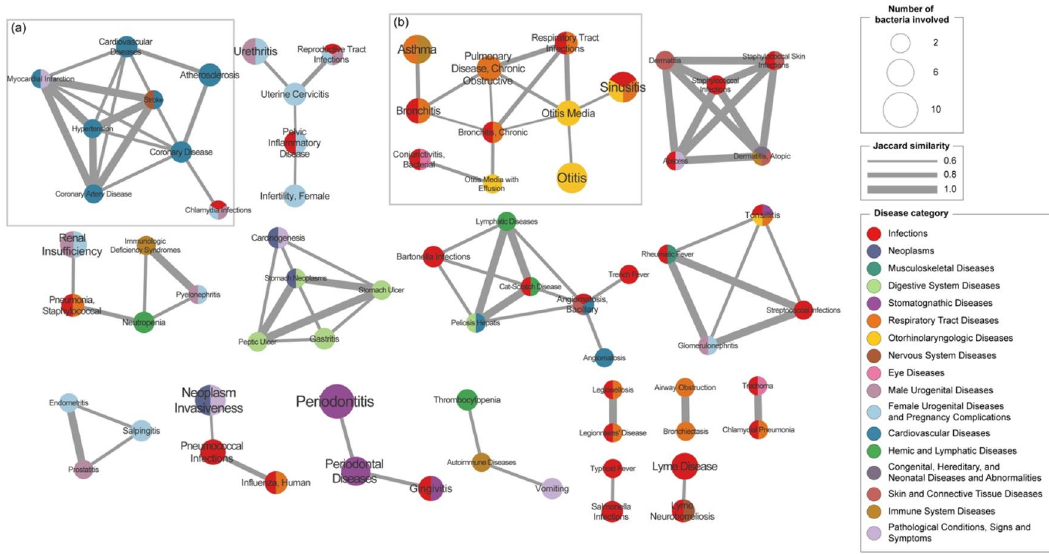
Figure 8. Disease similarity network. The network shows Jaccard similarities among diseases calculated with relevant microbes. The size of node is proportional to the number of microbes involved. The color of node represents top-level MeSH disease categories to which the disease belongs. The disease nodes are connected by an edge if Jaccard similarity was 60% or more. The width of edge is proportional to the similarity among